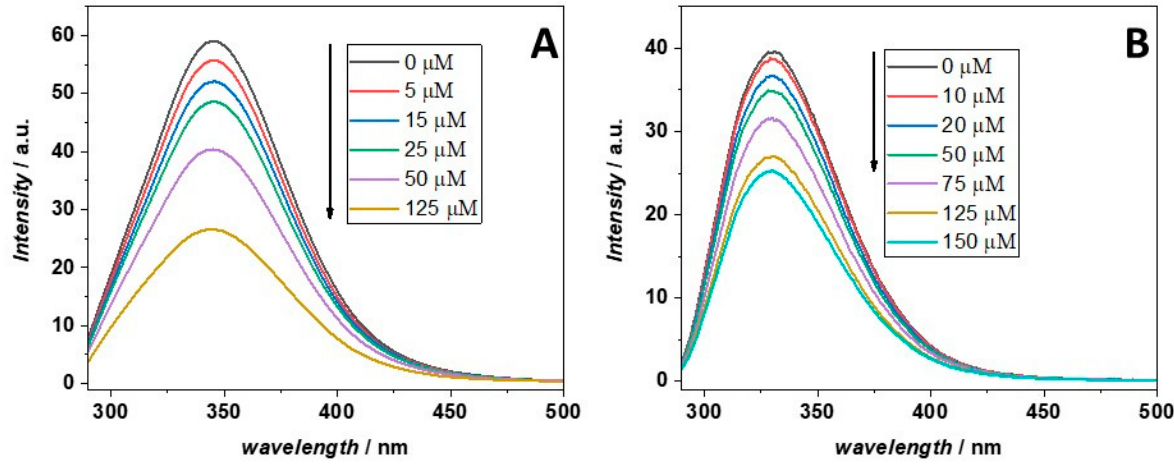
Figure 1. Fluorescence emission spectra at 20 ◦ C of ( A ) HSA and ( B ) hTf in the absence and presence of increasing concentrations of AziRu, as reported in the legend. The spectra of the proteins in the absence of the ligand are reported in black. The concentrations of HSA and hTf were kept constant at 5 µ M. The excitation wavelength was set at 280 nm. The fluorescence emission of HSA and hTf are centered at 345 and 330 nm, respectively. The arrows indicate the direction of the effects due to addition of increasing concentrations of AziRu.